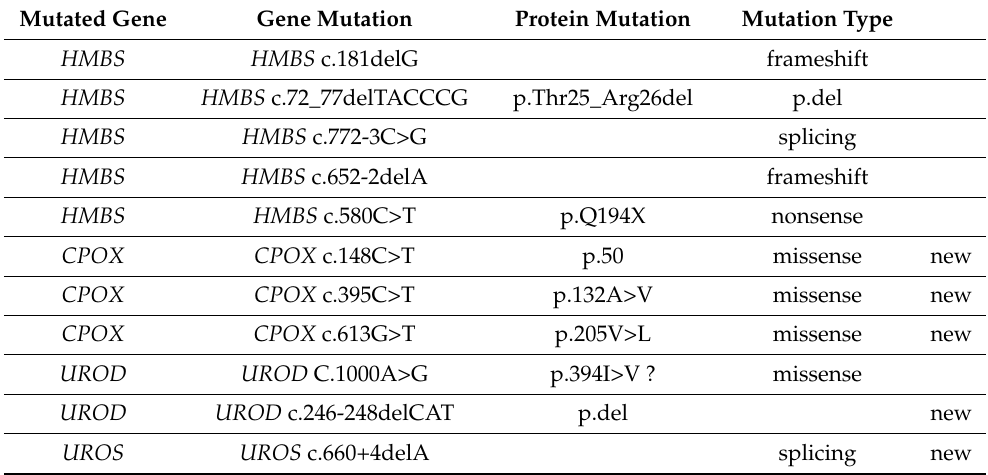
Table 2. Genes and proteins mutations found in the enrolled patients affected by